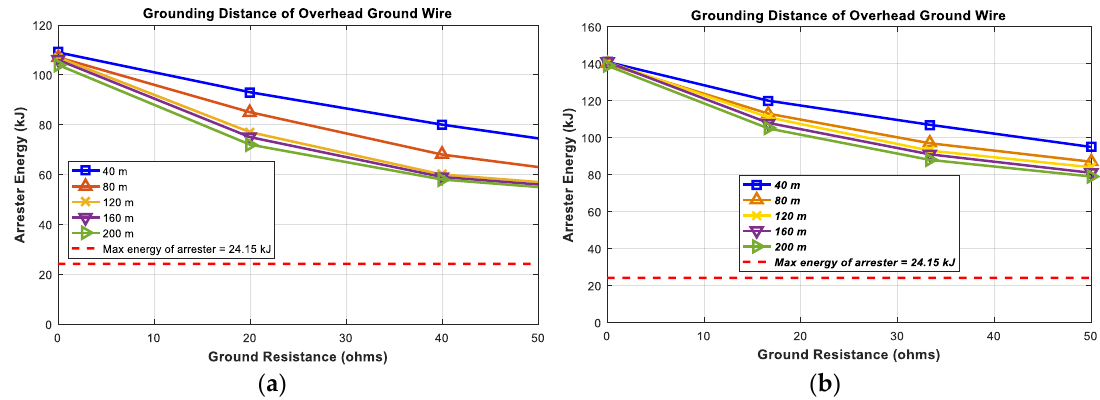
Figure 19. Arrester energy discharge in the case of a lightning strike to the phase conductor (lightning current wave shape = 4.12/77.5 μs, lightning current = 40 kA); ( a ) Strike to the middle of phase conductor; ( b ) Strike to the end of the phase conductor.